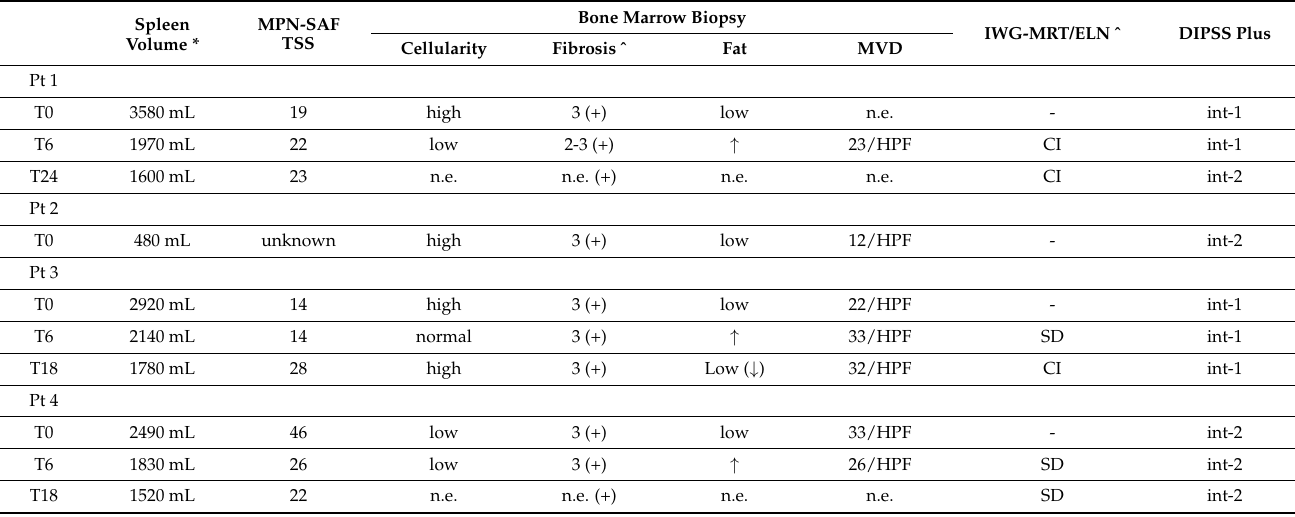
Table 3. Conventional response evaluation.